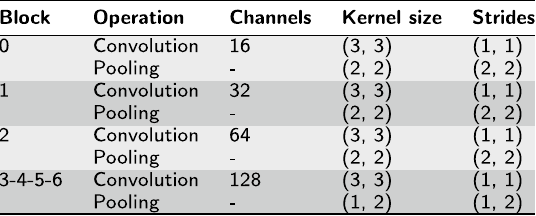
Table 3 Hyperparameters of convolutional feature